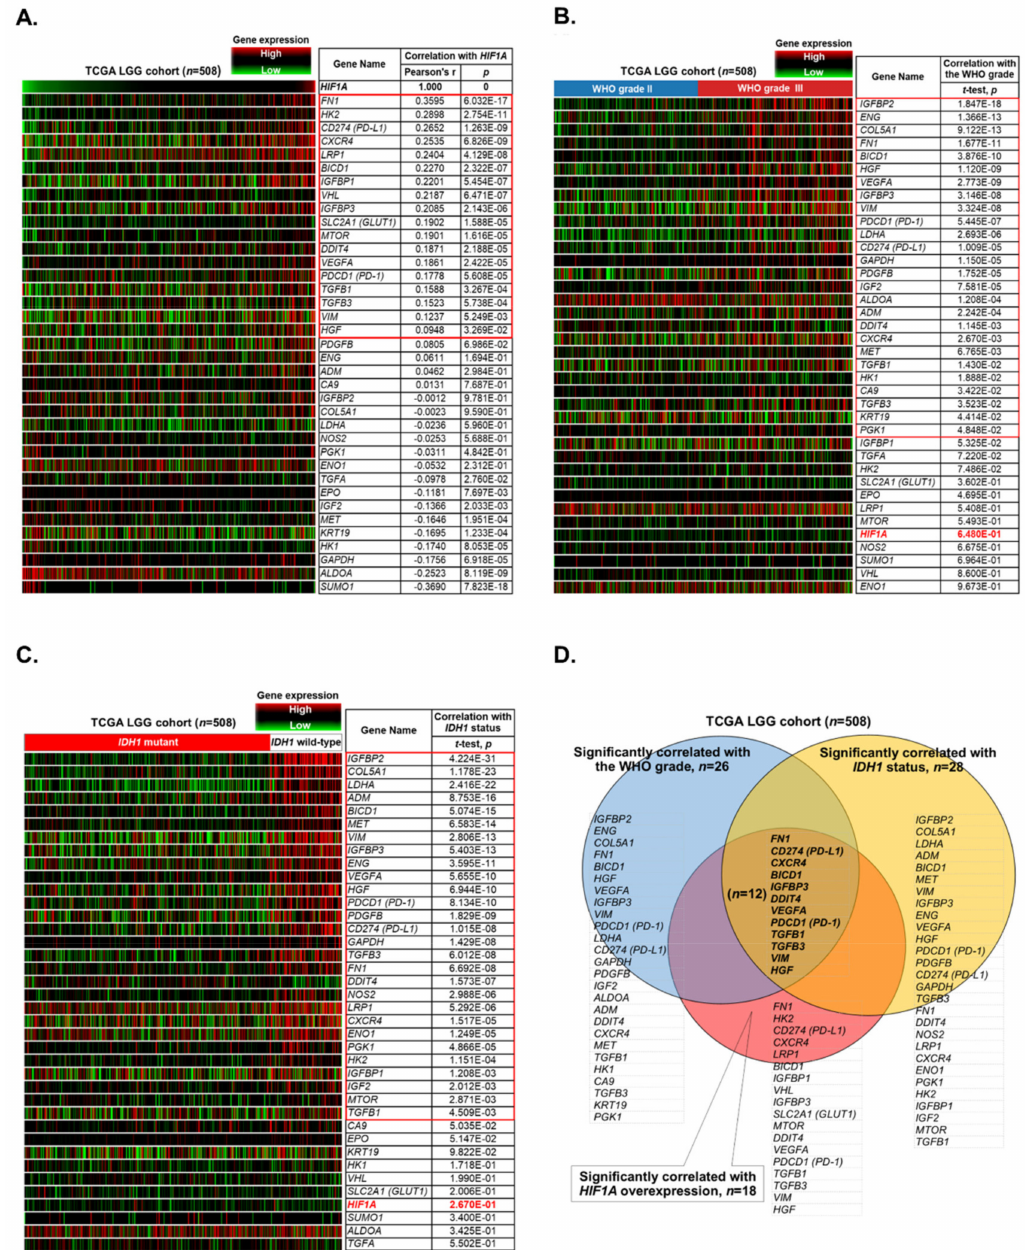
Figure 1. Identification of candidate biomarkers in the TCGA LGG database. ( A ). The heatmap revealed the correlations between the expression levels of 34 candidate genes and that of HIF1A . Those that were significantly and positively correlated with HIF1A upregulation were selected as candidate markers. ( B ). The heatmap revealed the correlations between the expression levels of 34 candidate genes and the WHO grade. Those that were significantly and differentially upregulated in grade III gliomas were selected as candidate markers. ( C ). The heatmap revealed the correlations between the expression levels of 34 candidate genes and IDH1 status. Those that were significantly and differentially upregulated in LGGs with wild-type IDH1 were selected as candidate markers. ( D ). The hierarchical method revealed the most qualified candidate markers that were compatible with all of our